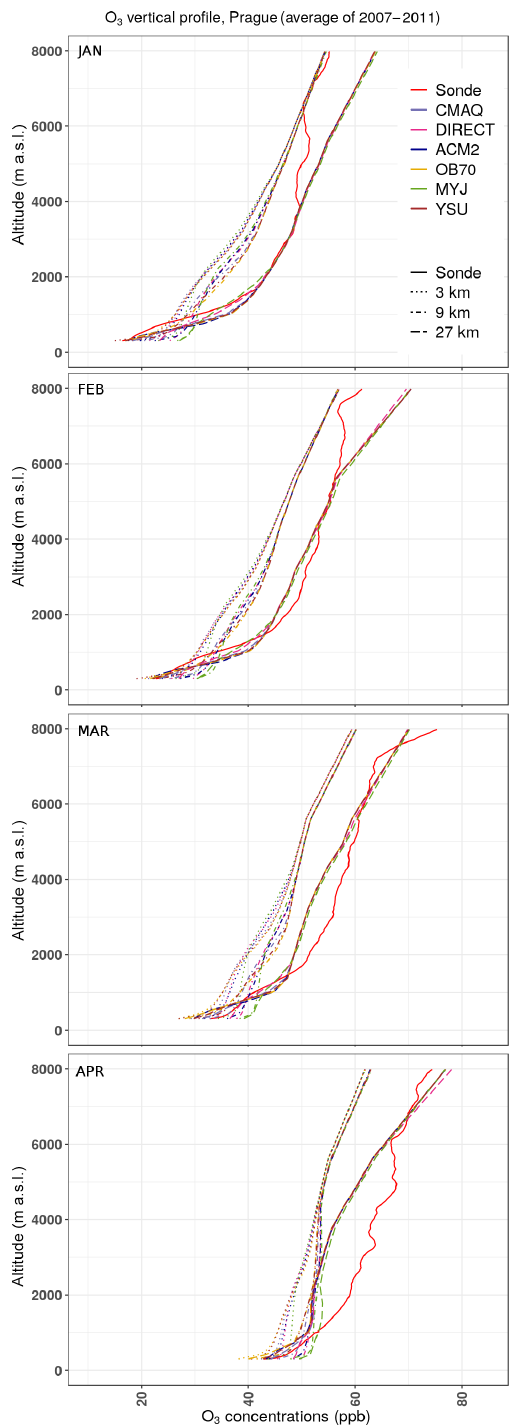
Figure 8. Comparison of monthly O 3 vertical profiles with sound- ing data for Prague, Czech Republic, for January–April. Solid red lines denote the measured data. Dashed, dot-dashed and dotted lines indicate the 27, 9 and 3km resolution model data, and differ- ent colors indicate different K v methods. Measurements are from 12:00UTC each day. Concentrations are in ppbv. The vertical axis indicates the elevation above sea